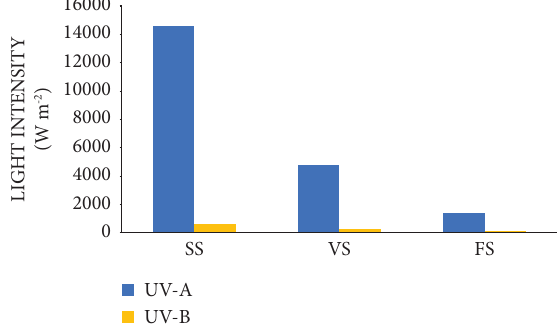
Figure 2: Ultraviolet (UV)-A and UV-B (B) at seedling, vegetative, and fowering stage under the intercropping canopy during the growth period at Hawassa. Where, SS � seedlingstage, VS � veg- etativestage, FS �